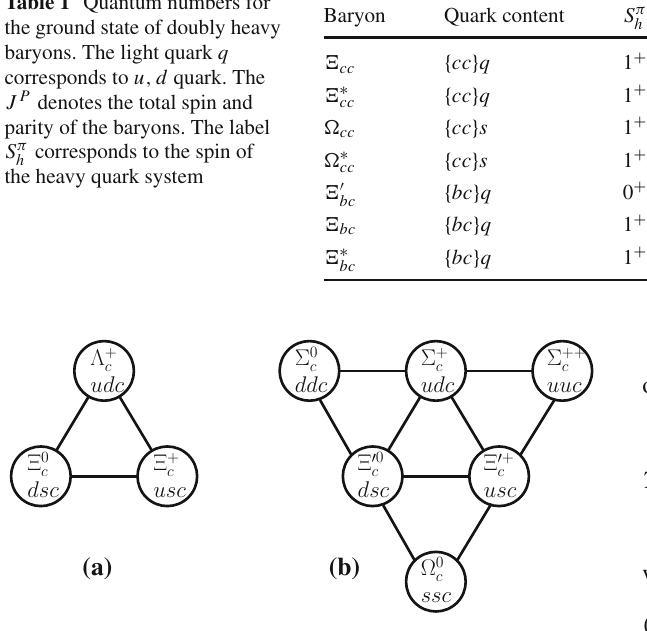
Fig. 1 Anti-triplets ( a ) and sextets ( b ) of charmed baryons with one charm quark and two light quarks